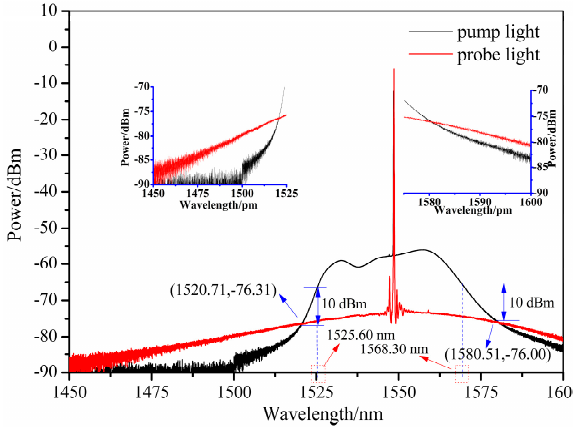
Figure 4. The emission spectrum of the hybrid system.